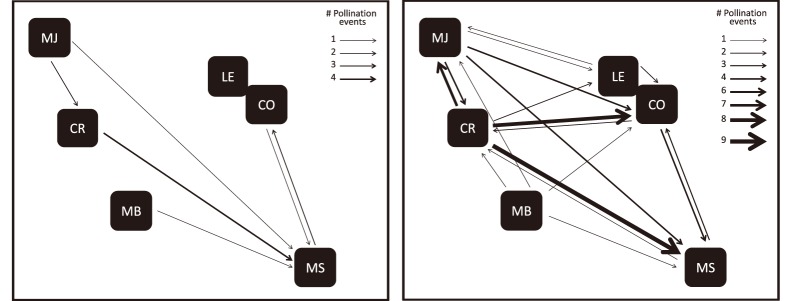
Long-distance (between-population) realised pollen flow directions for Glionnetia sericea based on (a) assignments with 95% CI and (b) assignments with 80% CI.The arrows give the pollen flow directions and the thickness represents the observed numbers of pollination events.